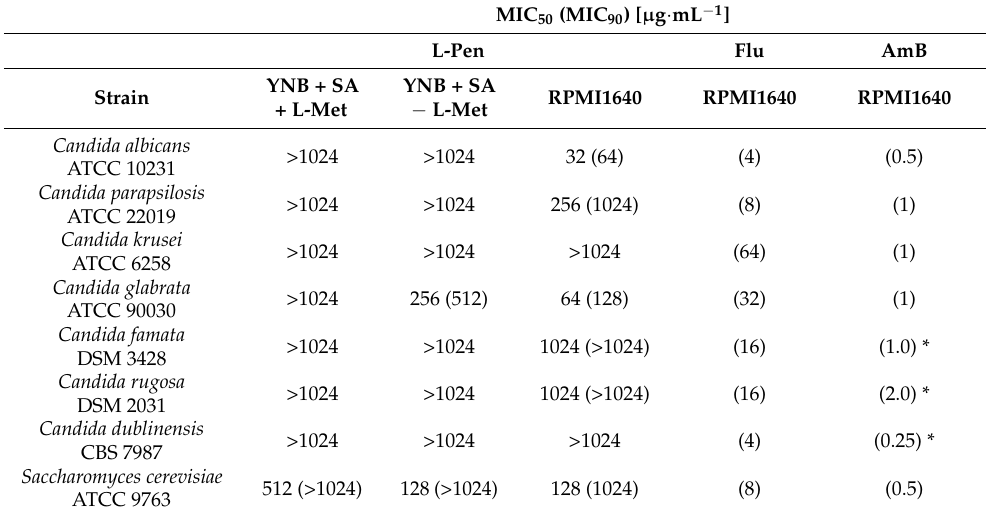
Table 2. Susceptibility of fungal strains to L-Pen, D-Pen, fluconazole (Flu), and amphotericin B (AmB). MIC 50 (MIC 90 ) are the compound concentrations at which growth is inhibited by 50% or 90%, respectively. > Indicates no activity at the mentioned concentration. The experiments were performed in at least three replicates. * Data retrieved from